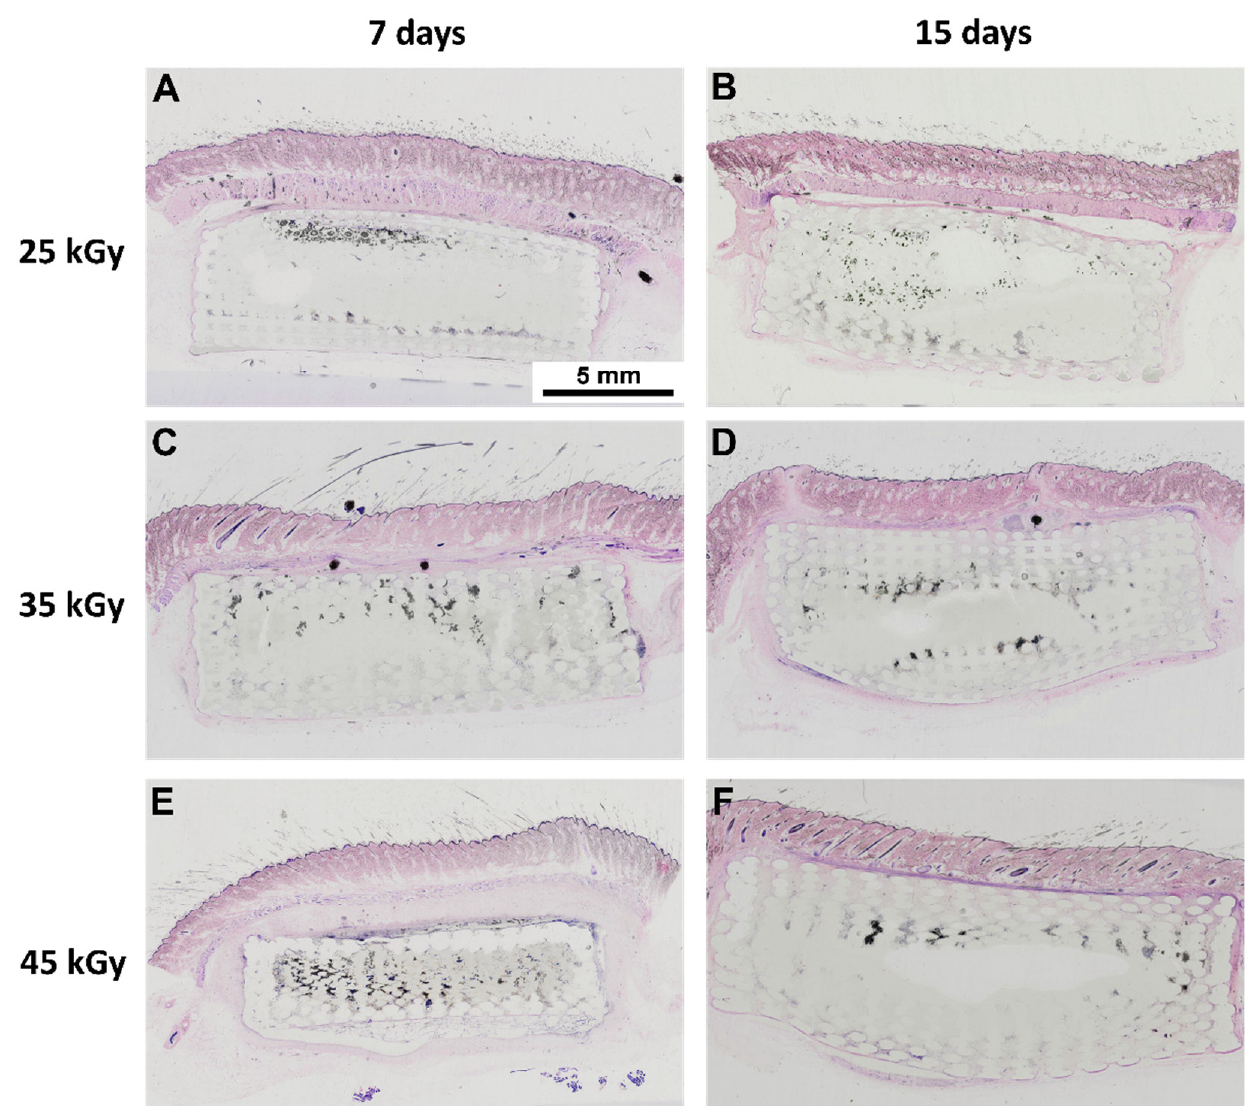
Figure 6. Histological images, stained with H&E, scanned using an Olympus Virtual Microscopy System VS110TM at 20× magnification, of the subcutaneously implanted 3D PCL scaffolds in the rat animal model. Representing the left panel and the right panel, 7 days, and 15 days recovery time, respectively. ( A , B ) scaffolds were sterilized with 25 kGy gamma radiation, ( C , D ) with 35 kGy and ( E , F ) with 45 kGy. Scale bar 5 mm.